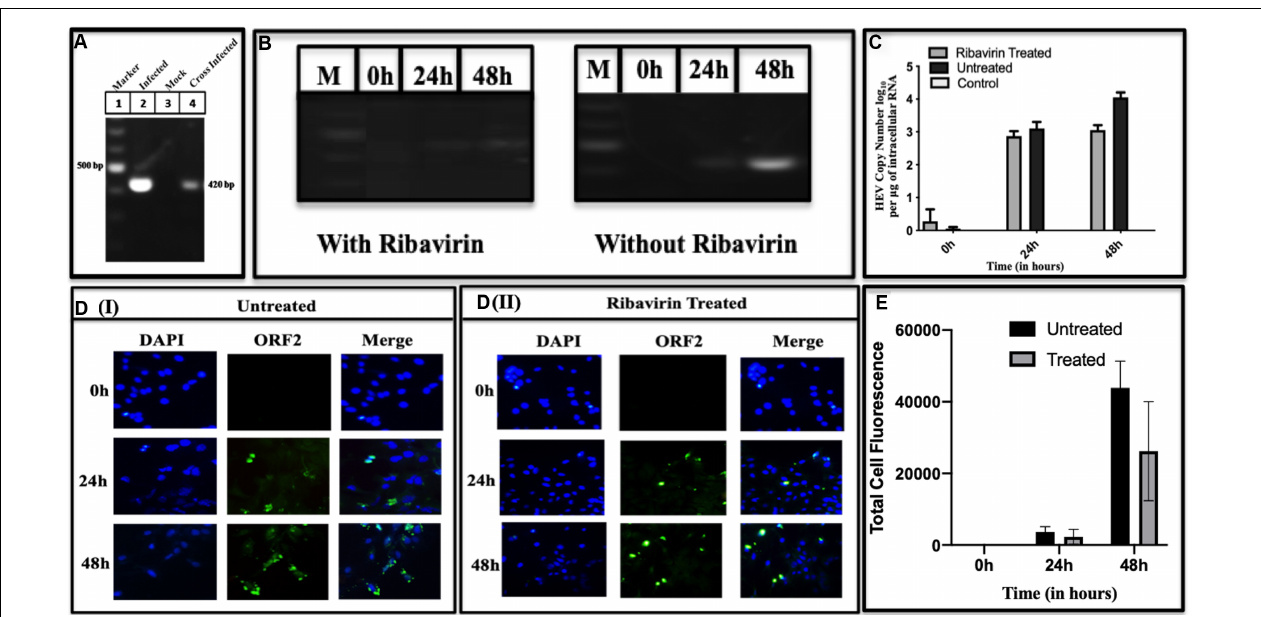
FIGURE 3 | Cross-infectivity of HEV in Huh7 cells. Lysate of the cells infected with BacMam-HEV adsorbed on the uninfected Huh7 cells. (A) RT-PCR for HEV ORF2 region. The corresponding lanes are as follows: Marker (lane 1), BacMam-HEV infected cell lysate (lane 2), control cells lysate (without infection) (lane 3), Huh7 cells adsorbed by the cell lysate of virally infected cells (lane 4). (B) It represents the RT-PCR of Ribavirin treated and untreated cells at 0, 24, and 48 h, respectively. M represents Marker. (C) qPCR was used for quantification of HEV copy number of uninfected, Ribavirin Treated and Untreated Cells. Statistical significance of Data was tested using 2-way ANOVA. The data was statistically significant as the p -value < 0.05 ( p -value 0.0019, 0.0039, < 0.0001). All the experiments were done in duplicates, and the error bar indicates the standard deviation. The values represent the mean of three independent experiments. (D) Immunofluorescence at different time points. Panels (DI,DII) show the intensity of ORF2 at 0, 24, and 48 h in cross-infected cells without Ribavirin treatment and with Ribavirin treatment, respectively. The cells were stained with Anti-ORF2 primary antibody, which was detected with Alexa Fluor 488 goat Anti-Rabbit IgG secondary antibody. (E) Quantification of fluorescence. The intensity of fluorescence was quantified with ImageJ software. Total four cells were selected to quantify the fluorescence intensity. The bar graph represents the mean fluorescence intensity, and the error bar indicates the standard deviation. The statistical significance of data was tested by GraphPad prism using 2way ANOVA. ( p -value = 0.0247, < 0.0001, 0.0278) p -value < 0.05 is considered as significant. All the experiments were performed at least three times as independent